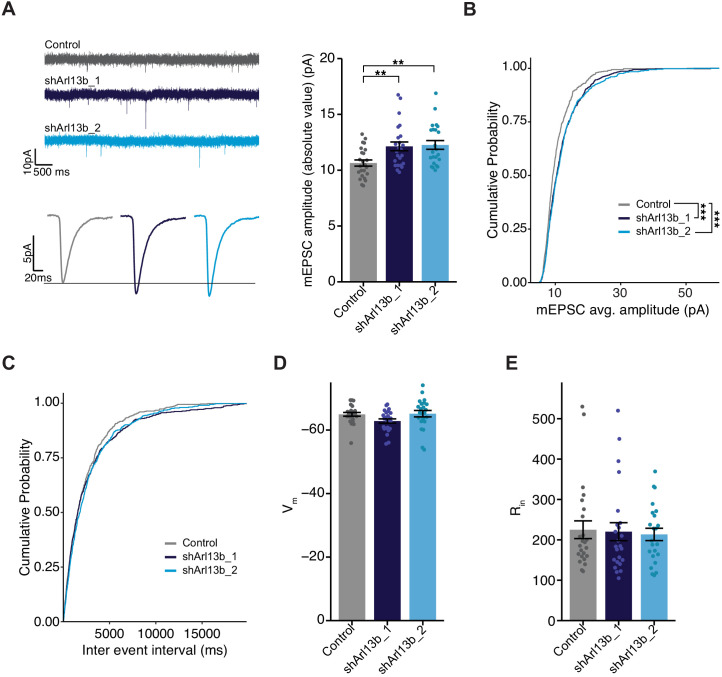
Mean mEPSC amplitude in pyramidal neurons is increased following acute reduction of ciliary signaling.(A) (Left) Representative mEPSC traces (top) and average waveforms (bottom) from neurons transfected with the indicated plasmids. (Right) mEPSC amplitude from neurons transfected with the indicated plasmids. Each dot represents the average amplitude for a given neuron. Bars are average ± SEM. ** indicates the difference between indicated values at p<0.01 (Kruskal–Wallis with Dunn’s multiple comparisons test). n: Control = 24, shArl13b_1 = 24, shArl13b_2 = 23; >5 dissociations. (B and C) Cumulative distribution probabilities of mEPSC amplitudes (B) and inter-event intervals (C) from neurons transfected with the indicated plasmids. *** indicates the difference from control at p<0.001 (Kruskal–Wallis with Bonferroni correction). (D and E) Average resting membrane potential (Vm) (D) and input resistance (Rin) (E) of neurons transfected with the indicated plasmids. Each dot represents a single neuron. Bars are average ± SEM. n: As in A.
Figure 3—source data 1.Source data for Figure 3.